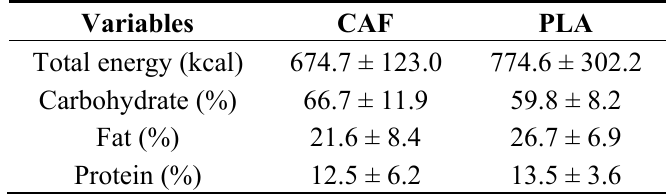
recovery for caffeine (CAF) and placebo (PLA) conditions (mean ± SD).